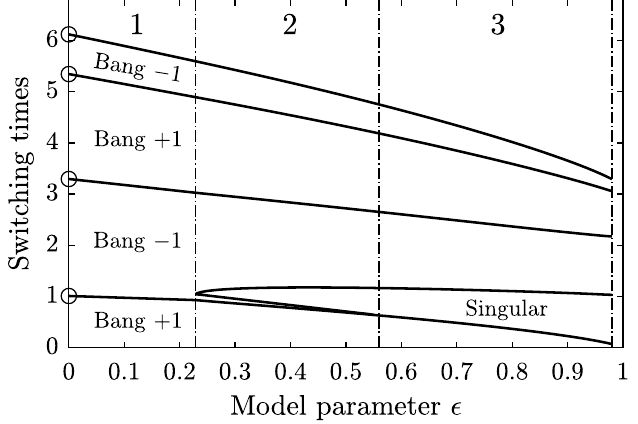
Figure 5. Structure of the optimal solution as a function of the model parameter (cid:101) : (1) bang-bang, (2) bang-bang-singular-bang, and (3) bang-singular-bang. The solid lines represent the switching times between the bangs, while the vertical dash-dot lines denote (cid:101) = 0.23, (cid:101) = 0.56, and (cid:101) = 0.98.